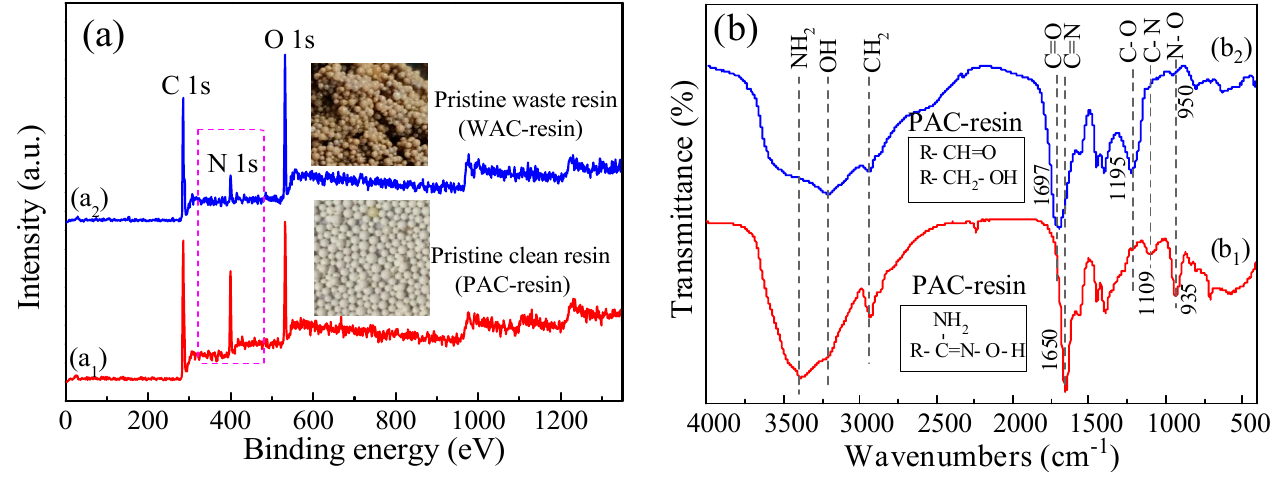
Figure 3. ( a ) XPS survey spectra and ( b ) FTIR spectra of the PAC-resin and